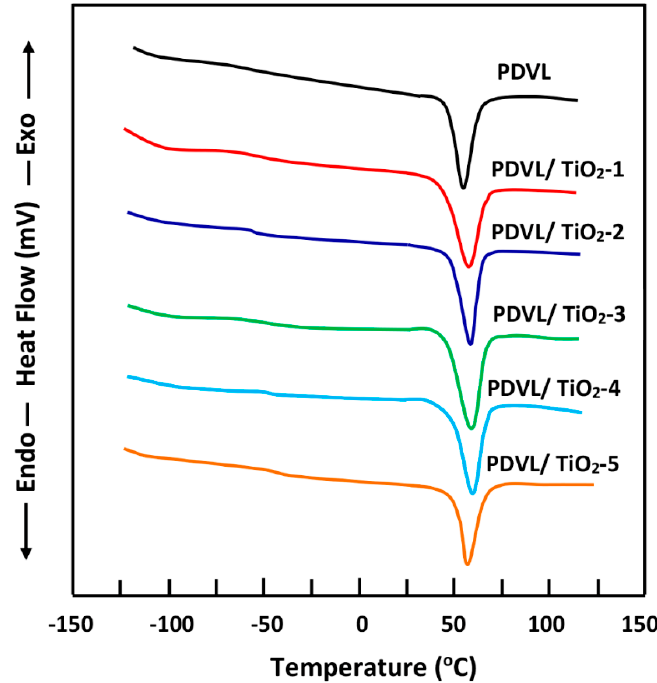
Figure 4. Differential scanning calorimetry (DSC) thermal curves of pure PDVL and PDVL/TiO 2 nanocomposites containing different TiO 2 contents taken in the heating mode with a heating rate of 20 °C·min − 1 .